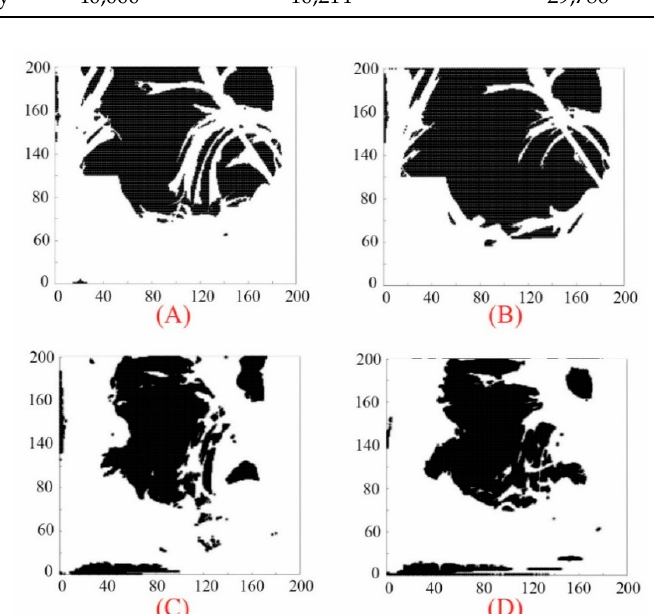
Figure 27. Eliminated grids for ( A ) phase fraction, ( B ) pressure, ( C ) x -direction-velocity, ( D ) y - direction-velocity. Table 4. Percentage of eliminated data for each parameter.